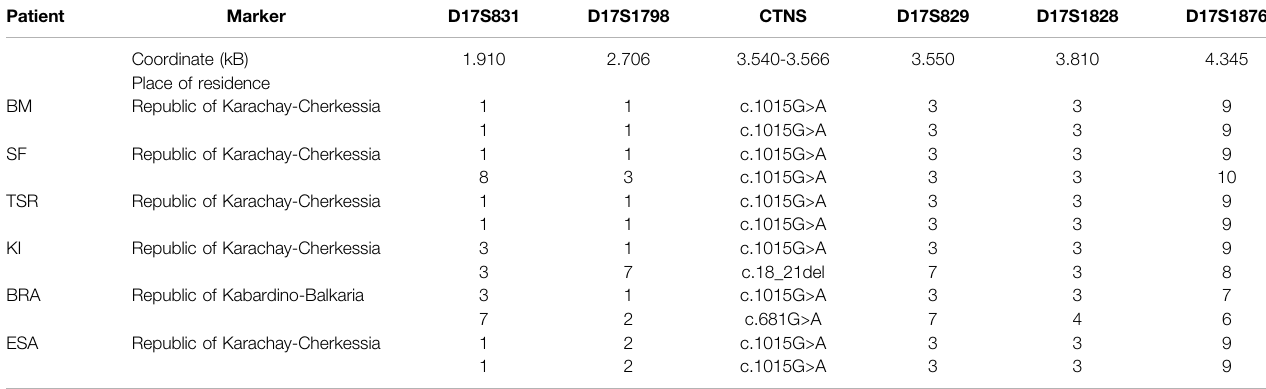
TABLE 3 | Haplotypes of chromosomes with the c.1015G > A mutation for markers D17S831-D17S1798-D17S829-D17S1828-D17S1876. Patient